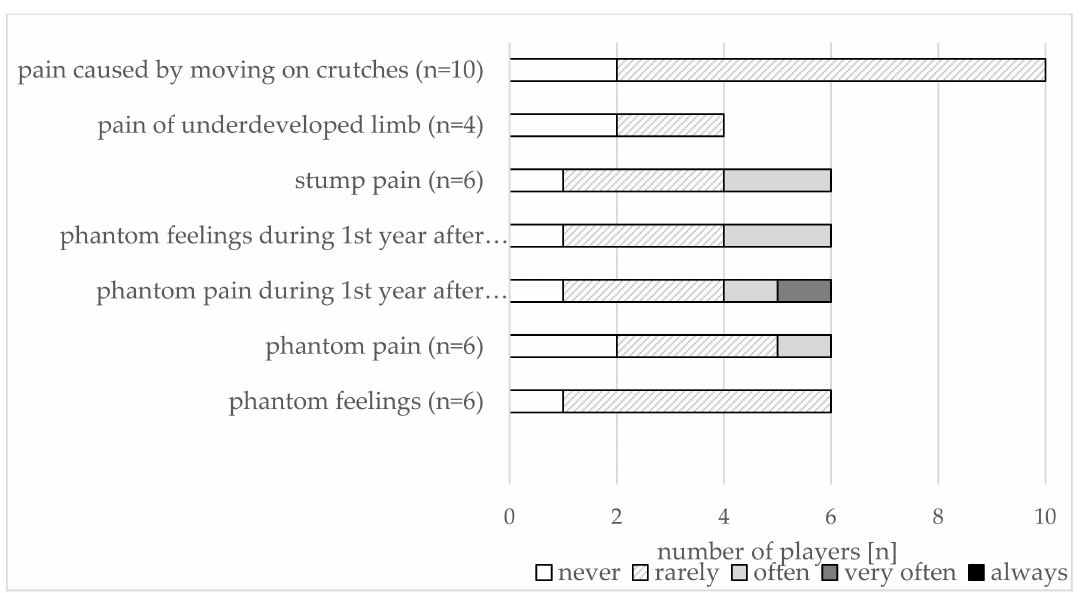
Figure 3. The frequency of phantom pain, stump pain and pain identified as coming from moving on crutches to disability in Amputee Football field players. Different n numbers: n = 10 for all field players, n = 4 for players with congenital agenesia, n = 6 for players with lower limb